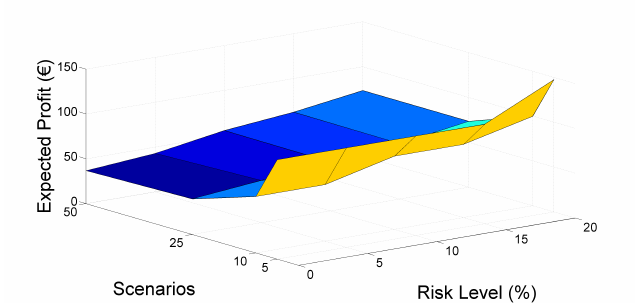
Figure 1. Expected profit by scenarios and risk level for the Big-M method applied to the TSO balance constraint.